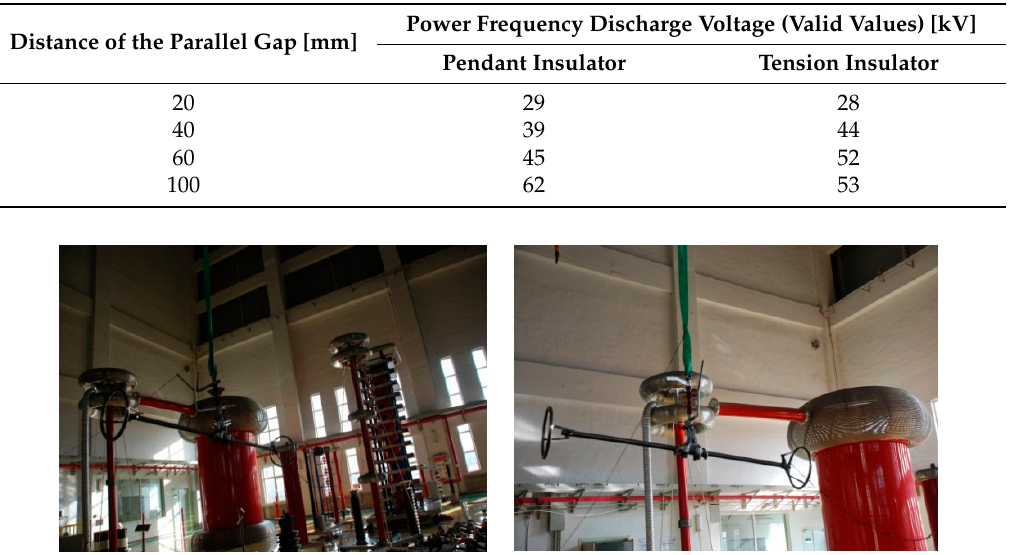
Figure 3. Pictures of power frequency discharge voltage testing in the UHV DC base of SGCC.